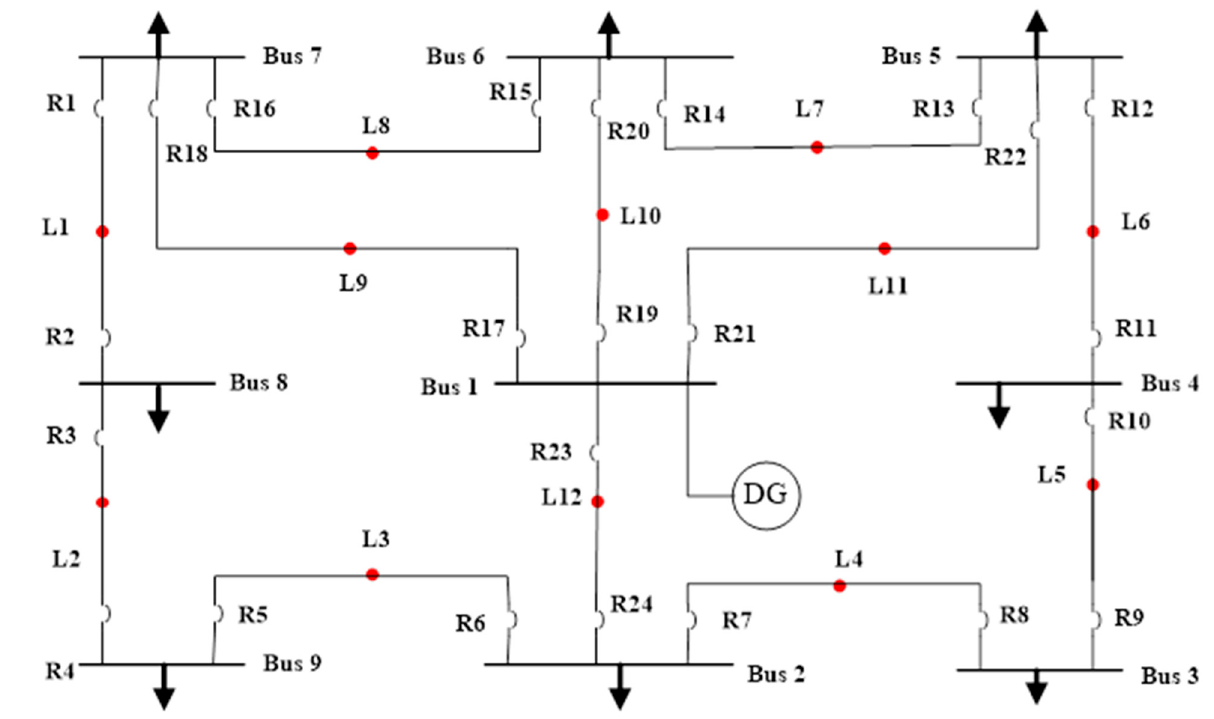
Figure 2. Single line diagram of IEEE 9-bus system.